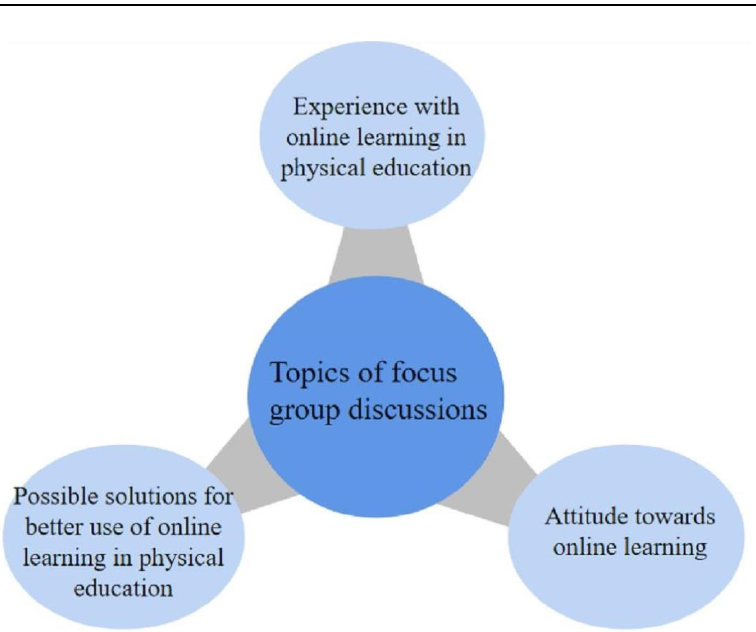
Figure 1. Topics for focus group discussions.